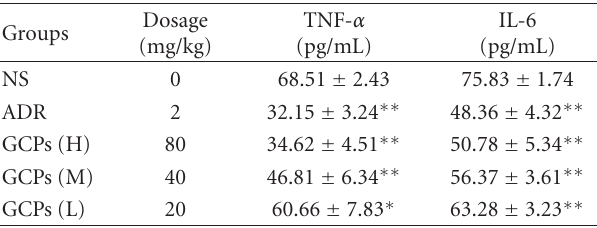
P < 0.01, ∗ P < 0.05 versus